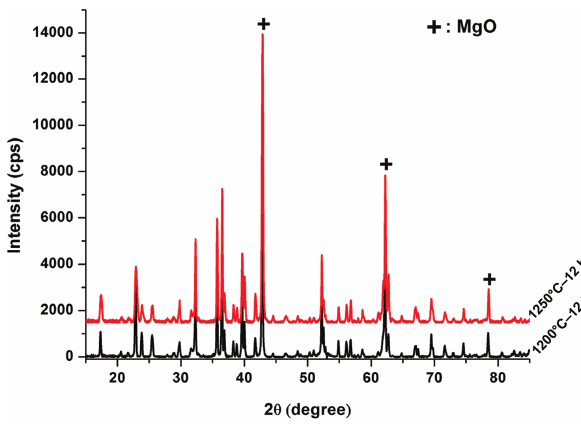
Figure 6: The XRD patterns at different sintering temperatures of Mg 3 SiO 5 : Eu 3+ , Dy 3+ .